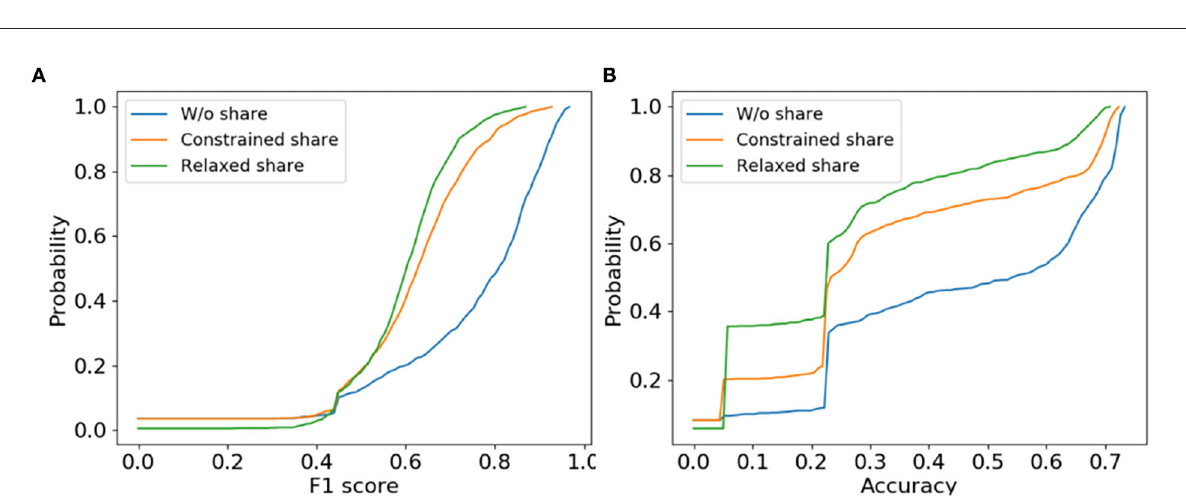
FIGURE4 The cumulative distribution of validation accuracies of the 1,000 sampled architectures for AGNN under the constrained/relaxed/without parameter sharing. (A) PPI and (B)